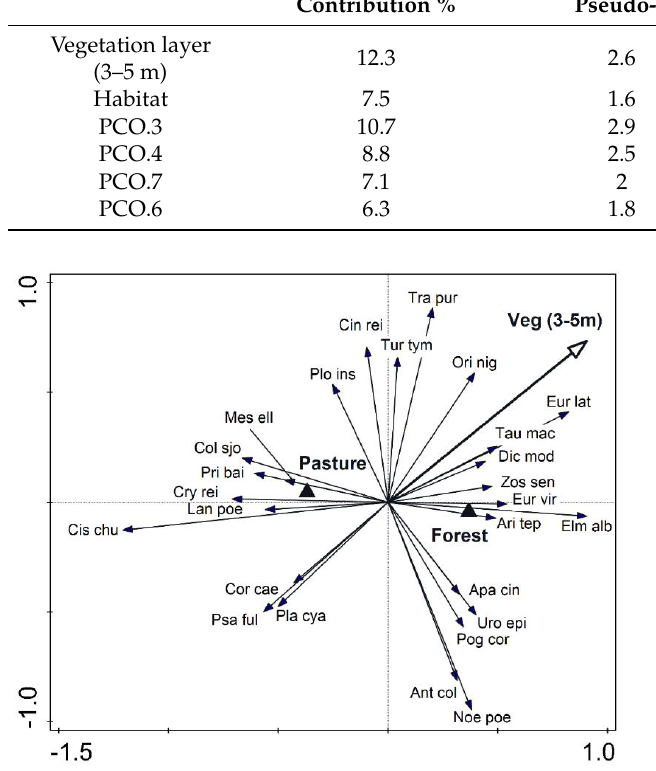
Table 4. The results of the PCNM analysis on the effect of environmental variables on the bird community structure. I and II ordination axes together explained 16.5% of variability. PCO—space predictor. Contribution % Pseudo-F